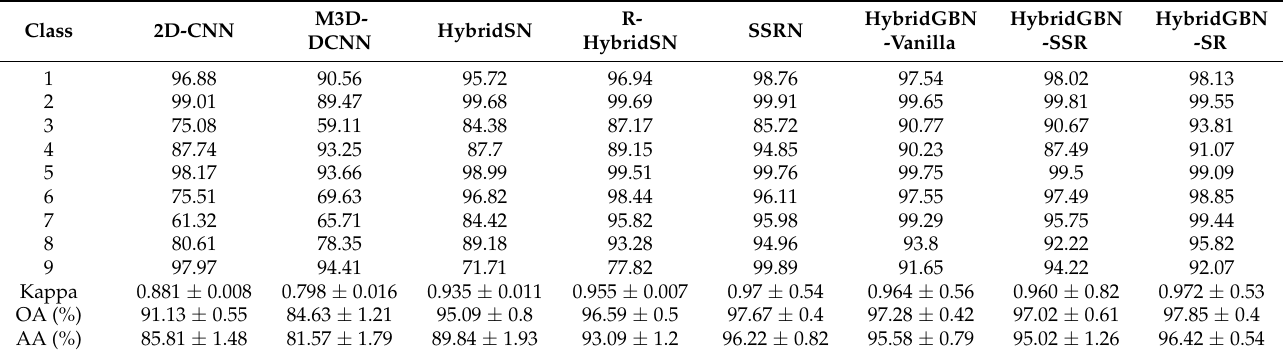
Table 5. The Kappa, OA, and AA results in a percentage of the compared models at 1% training sample data over the UP